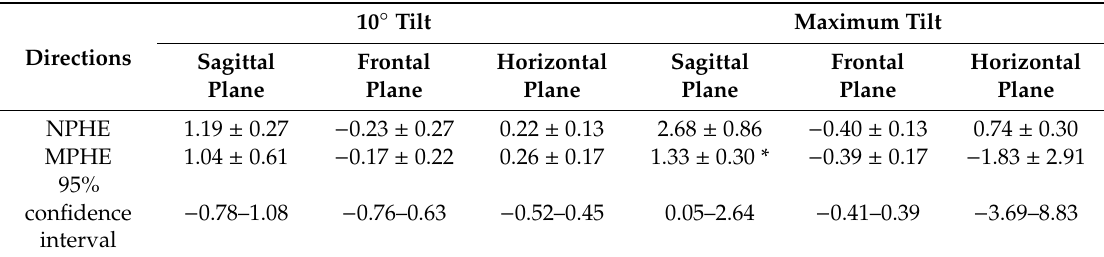
Table 3. Lumbar and hip joint movement ratio (lumbar / hip joint) (%) during PHE.